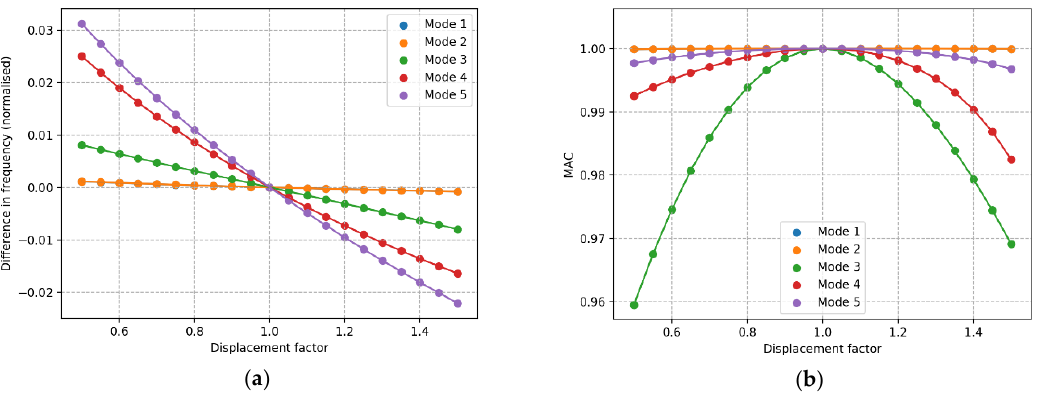
Figure 13. Effect of displacement factor compared to a factor of 1. ( a ) Difference in frequency, ( b ) MAC Figure 13. E ff ect of displacement factor compared to a factor of 1. ( a ) Di ff erence in frequency, value. ( b ) MAC